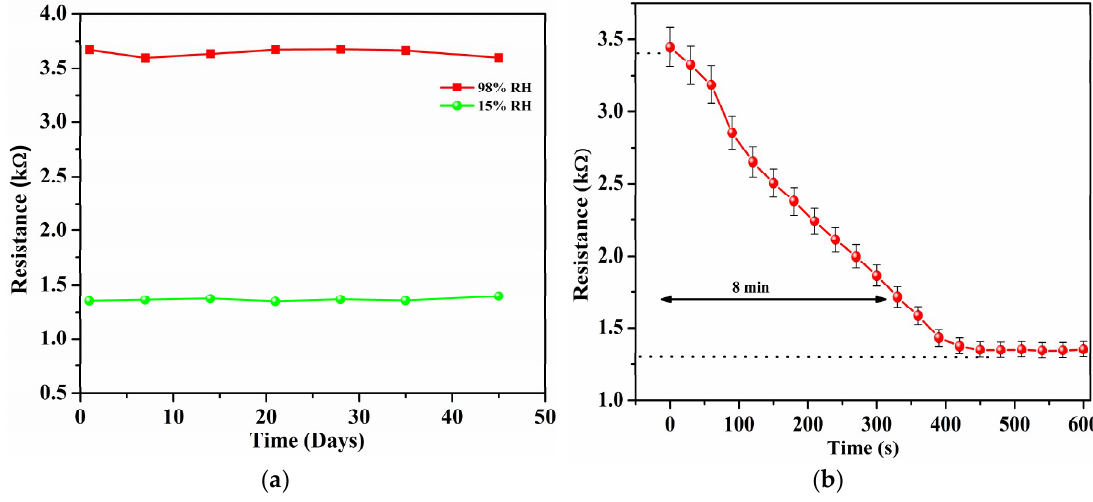
Figure 7. ( a ) Resistance as a function of time for suspended CNTs, indicating device stability, and ( b ) recovery time to 15% RH of the suspended CNTs after exposure to 98% RH for 24 h. Table 1. Comparison of the response and recovery times of different CNT humidity sensors.